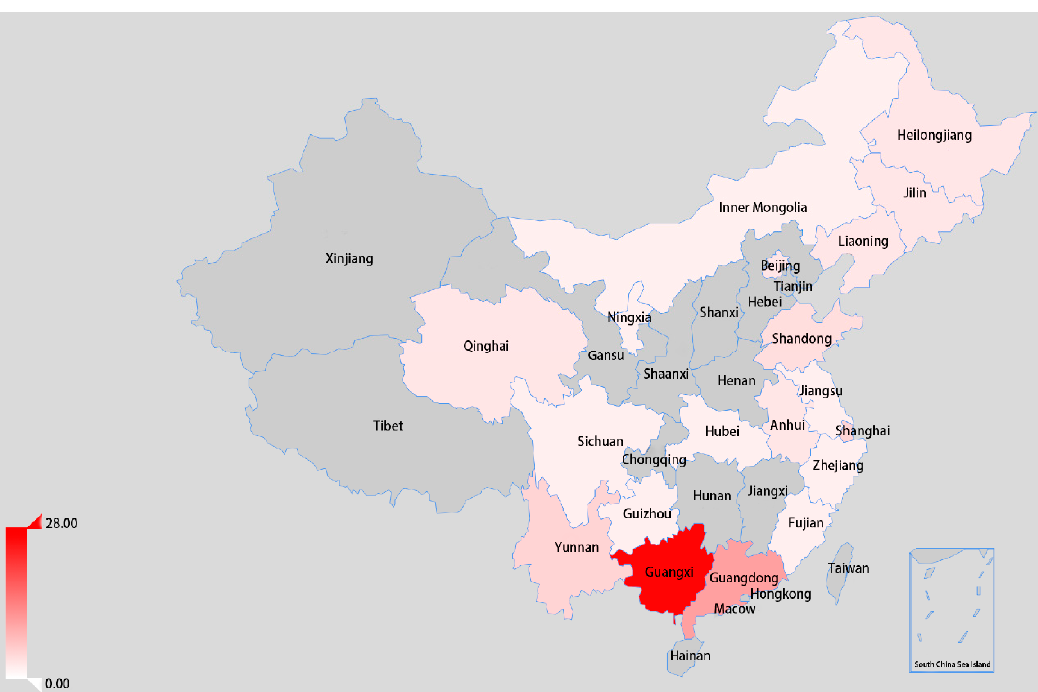
Figure 2. Distribution of VI.2.1.1.2.2 pigeon paramyxovirus type 1 (PPMV-1) isolated from China. The Chinese provinces where the presence of VI.2.1.1.2.2 PPMV-1 has been reported are indicated in red. All data were obtained from GenBank in NCBI [37].